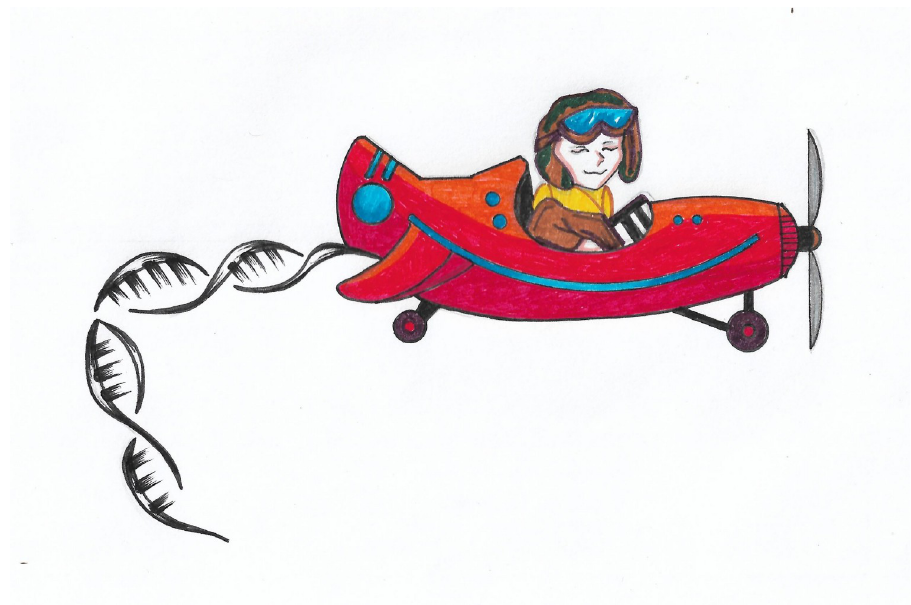
Fig 8. Stop the prejudices. “The most difficult thing is the decision to act. The rest is merely tenacity”—Amelia Earhart (Illustrated by Jose Faustino Villa).